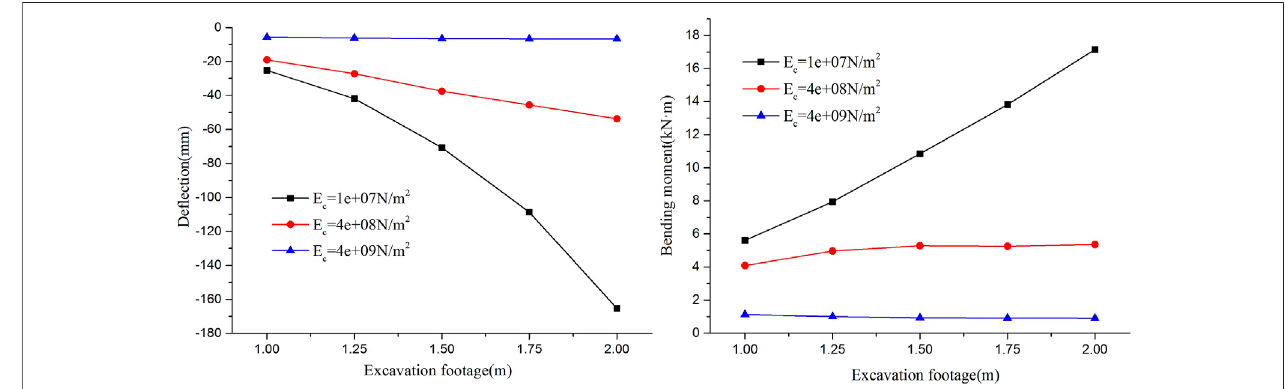
FIGURE 13 | When the diameter is 89 mm, the relation between excavation footage and de fl ection and bending moment under different elastic moduli of convergence area.